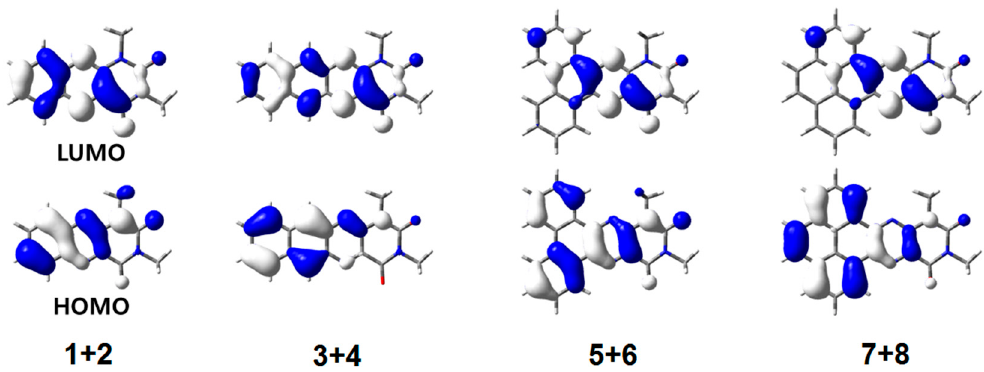
Figure 5. Highest occupied molecular orbital (HOMO) and lowest unoccupied molecular orbital (LUMO) contour dia- grams for the alloxazine derivatives calculated with DFT. Alkyl chains considered only as α -CH 2 . Flavins denoted as 1+2 (phenyl moiety), 3+4 (naphthalene moiety), 5+6 (phenanthrene moiety), and 7+8 (pyrene moiety). An isodensity value of 0.03 electrons Å − 3 was applied for the representations.